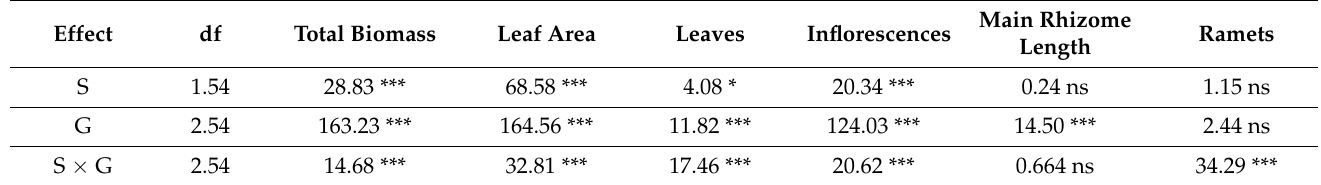
Table 2. F values of ANOVA effects of severing and grazing on clone morphological characteristics. Numerator and denominator of degrees of freedom (df) are given. A significant severing by grazing interaction (S × G) indicates a different response to grazing when the plant was severed. Significance levels indicated by, ns p > 0.05; * p < 0.05; *** p < 0.001. Main Leaf Area Leaves